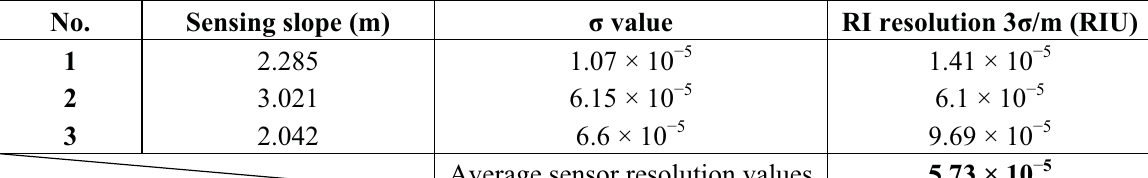
Table 7. Results of the sensing experiment for PPR fiber